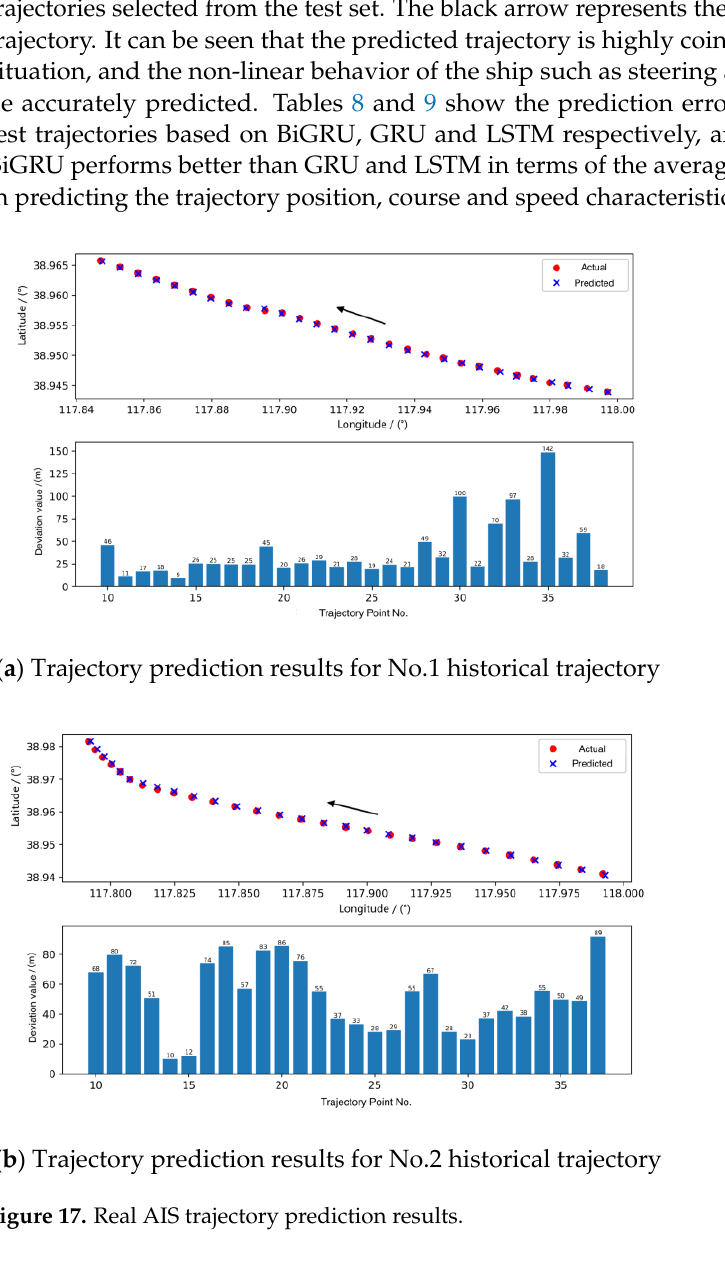
Figure 18. Comparison of prediction errors between BiGRU, GRU and LSTM. 4.3.2. Ship Abnormal Behavior Detection In this study, we consider vessel trajectory states that do not comply with the traffic patterns in the water as vessel anomalous behaviour, and three aspects are monitored: position, speed and course. Following the method in Section 3.2, we set the low threshold for ship position detection to 100 m and the high threshold to 250 m, and the anomaly thresholds for both heading and speed to ±3% of the predicted normative values.